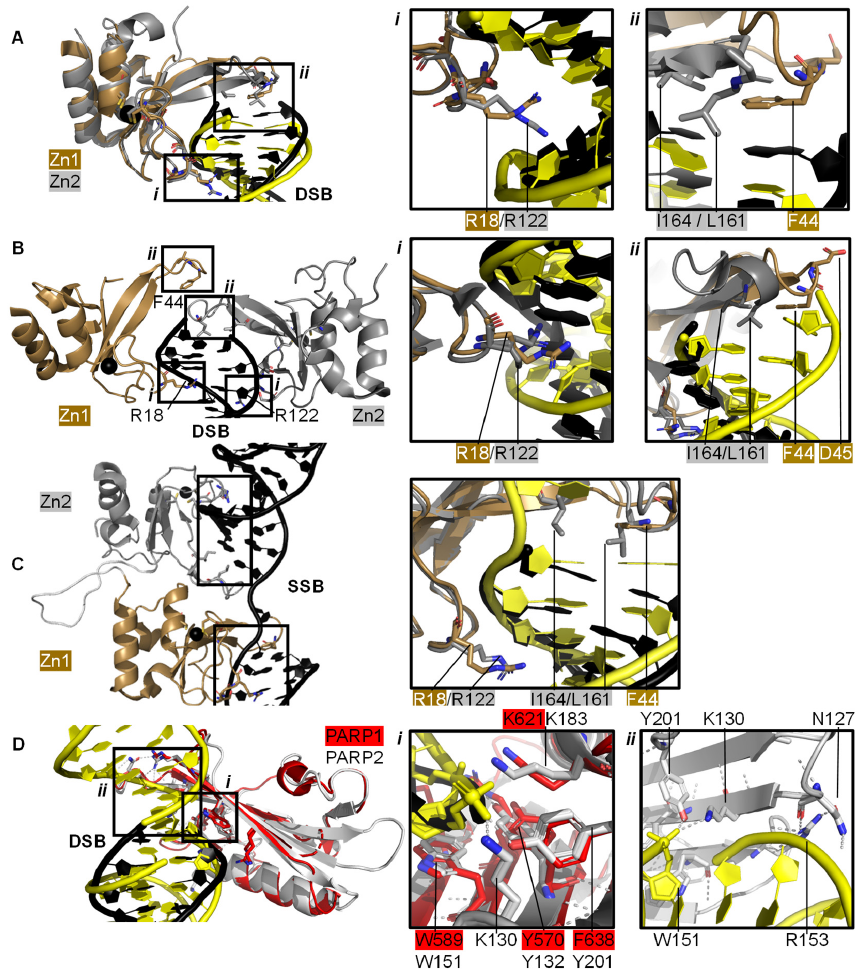
Figure 2. PARP domains in complex with a DNA DSB model ( A , B ), SSB ( C ), or DSB ( D ). ( A ) Superposed crystal structures of Zn fingers 1 (Zn1, brown, PDB 3ODA [86]) and 2 (Zn2, silver, PDB 3ODC [86]), RMSD 0.96 Å, in complex with DSB models shown in black for Zn1 and yellow for Zn2. Inset i shows the phosphate backbone grip and inset ii the base stacking loop; ( B ) Zn1 (brown) and Zn2 (silver) cooperate DSB model binding (PDB 4AV1 [87]). Insets show the superposition of Zn1 and Zn2 with an RMSD of 0.80 Å of the boxed regions. In the superposition, Zn1 and Zn2 binding to a DSB model is shown in black and yellow, respectively, where i shows the Zn finger loop with R18/R122 interacting with the major groove of the DSB model and ii the base stacking loop with F44/L161/I164; ( C ) Zn1 and Zn2 also cooperate SSB binding (PDB 2N8A [89]). Inset shows the superposition of the boxed regions in Zn1 and Zn2 on a SSB with an RMSD of 0.83 Å, where DNA in yellow binds to Zn1 and DNA in black binds to Zn2; ( D ) Superposition of the WGR domains from PARP1 (red, PDB 4DQY [34]) on a black DSB model and PARP2 (white, PDB 6F5B [90]) bridging a yellow DSB with a 5’ phosphate group (C α RMSD of 0.89 Å). Inset i highlights the superposed WGR PARP1 and PARP2 residues involved in DNA binding. Inset ii shows how the WGR of PARP2 interacts with the second DSB using R153. The crystal structure of Zn finger 3 of PARP1 (Zn3, PDB 2RIQ) revealed a Zn finger fold different from Zn1/Zn2 [22]. Zn3 uses its N-terminal α -helical region to interact with the minor groove of DSBs [34]. Destabilisation of Zn3 (by the introduction of negative charges in the Zn finger domain structure) resulted in a full-length PARP1 mutant able to